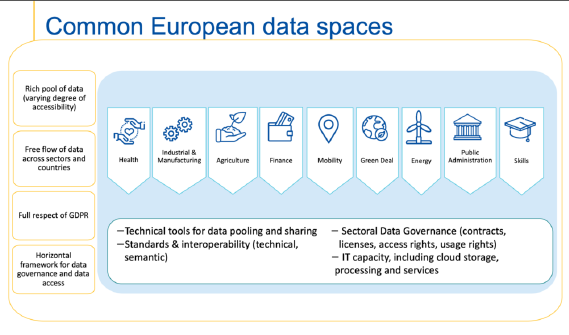
Figure 1. European Data Spaces Concept ((IDS, 2022)) subject to national or international jurisdictions having a rela- tion on the way data are collected, processed and used. ((Hum- mel et al., 2021)), as shown in Figure 2